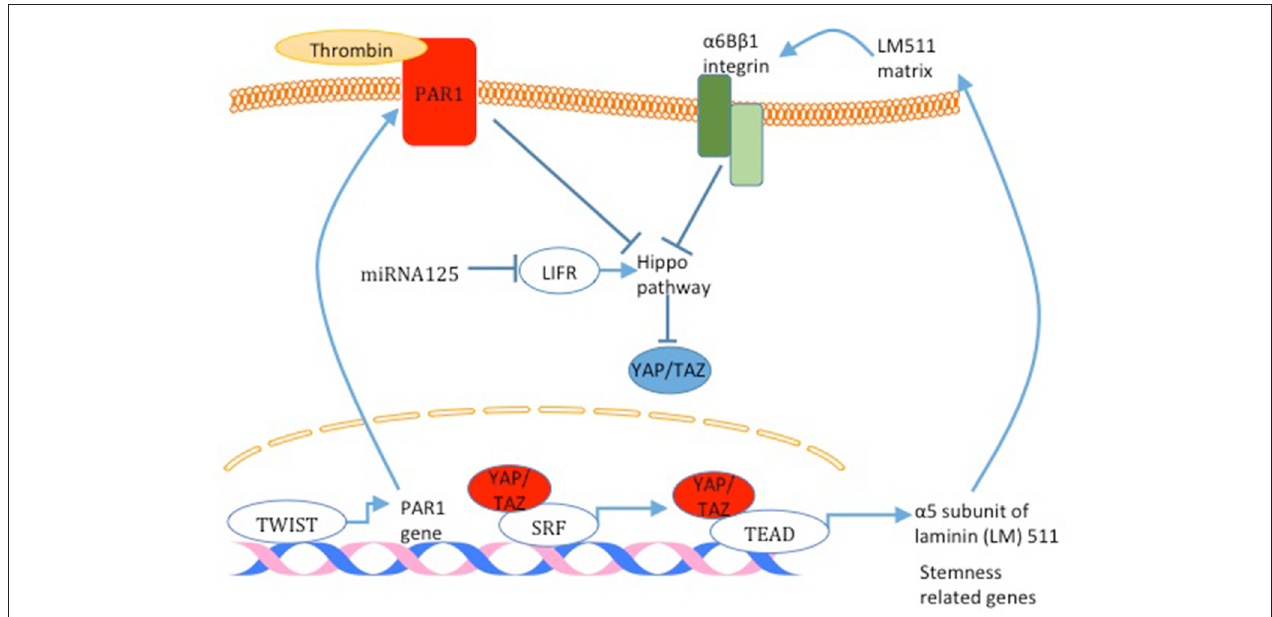
FIGURE 5 | Hippo pathway activity and breast cancer cell stemness. Different mechanisms responsible for Hippo pathway inactivation are illustrated in this figure. miRNA125 targets the Hippo pathway activator LIFR and induces TAZ activity. Also, TAZ was found to activate the expression of α 5 subunit of laminin (LM) 511 and the formation of a LM511 matrix. Reciprocally, LM511 activates α 6B β 1 integrin that activated TAZ. Finally, TWIST increases PAR1 expression which consequently inhibits the Hippo pathway and induces TAZ function. TAZ activation through all these mechanisms increases the expression of breast cancer cell stemness related genes.